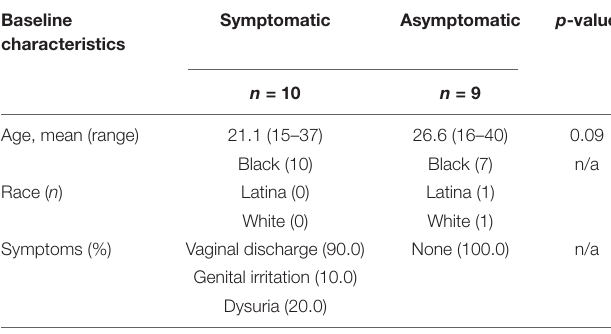
TABLE 1 | Study population characteristics at